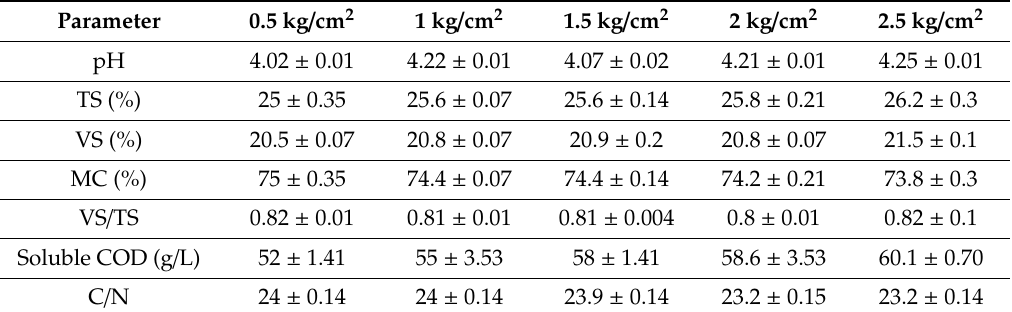
Table 3. Physicochemical characteristics of pretreated food waste at di ff erent pressures (0.5, 1, 1.5, 2 and 2.5 kg / cm 2